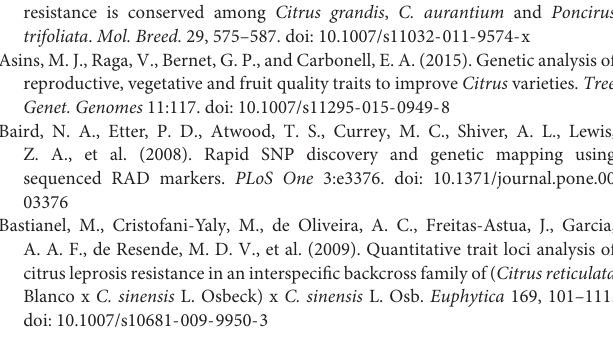
FIGURE S1 | Collinear analysis of consensus between genetic linkage maps and reference genome by dot-plot diagram. FIGURE S2 | Full genetic linkage maps and genome-wide LOD score graphics of QTL mapping of two phenotypic traits. FILE S1 | Summary of Genotyping by Sequencing for 170 F 1 progenies and four parental varieties. FILE S2 | Analysis of parental genotypes and distribution of SNP loci on reference genome in four parental